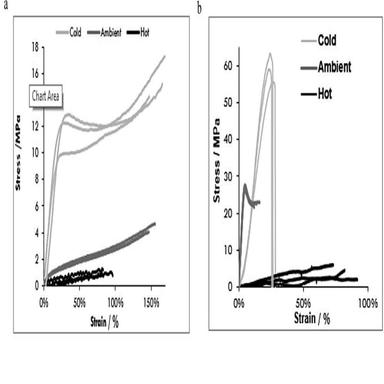
Mechanical response of (a) Tango Black Plus at 300 mm min1 , (b) VeroWhitePlus, (c) Rigid Light Grey at 1 mm min1 at different temperatures.